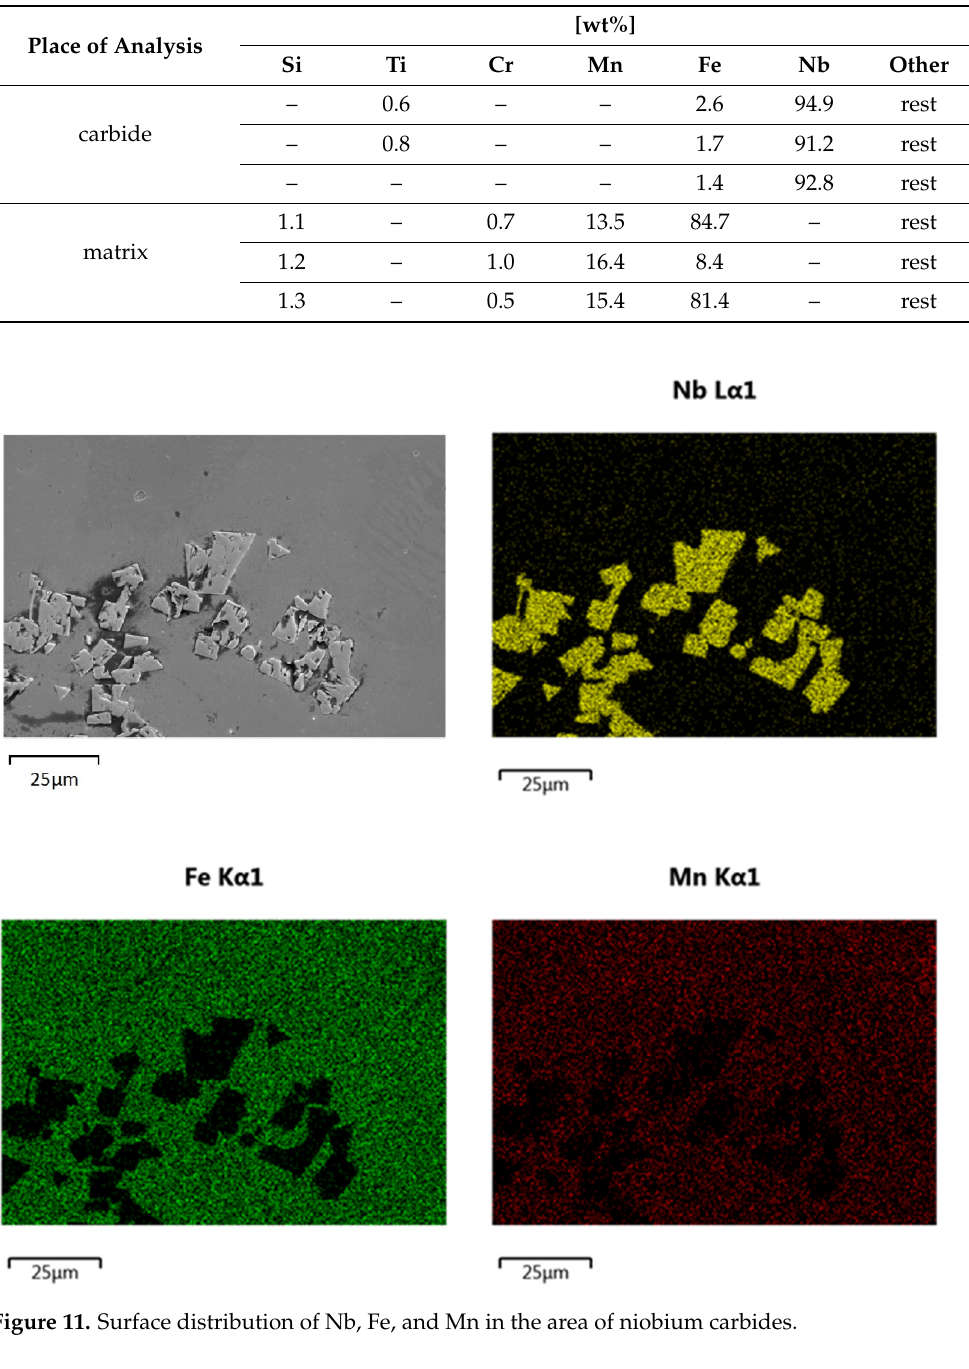
Table 3. Chemical composition in microregions of the alloy matrix and carbides.